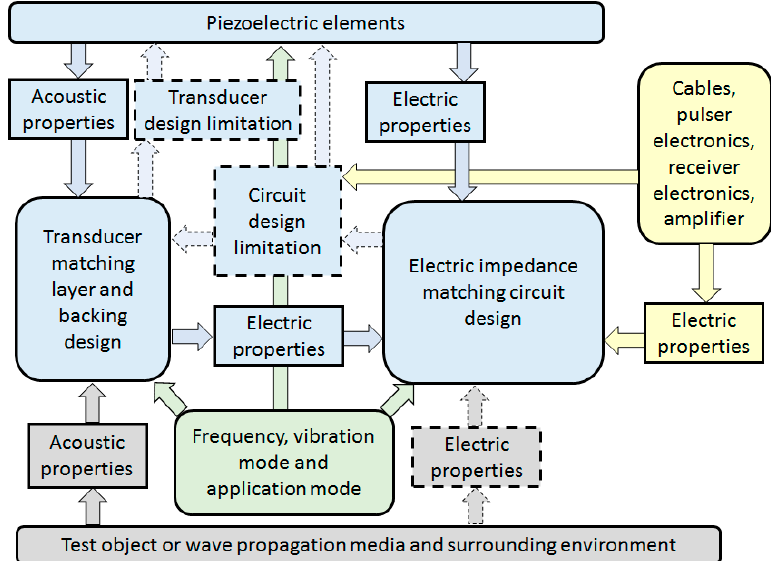
Figure 2. Schematic showing the process flow of electric and acoustic impedance matching involved in the design of piezoelectric receiver or transducer systems. The design elements indicated by dotted lines are uncommon and are used in the design of highly advanced transducers (such as very high frequency, high signal-to-noise ratio (SNR) and low-power considerations).